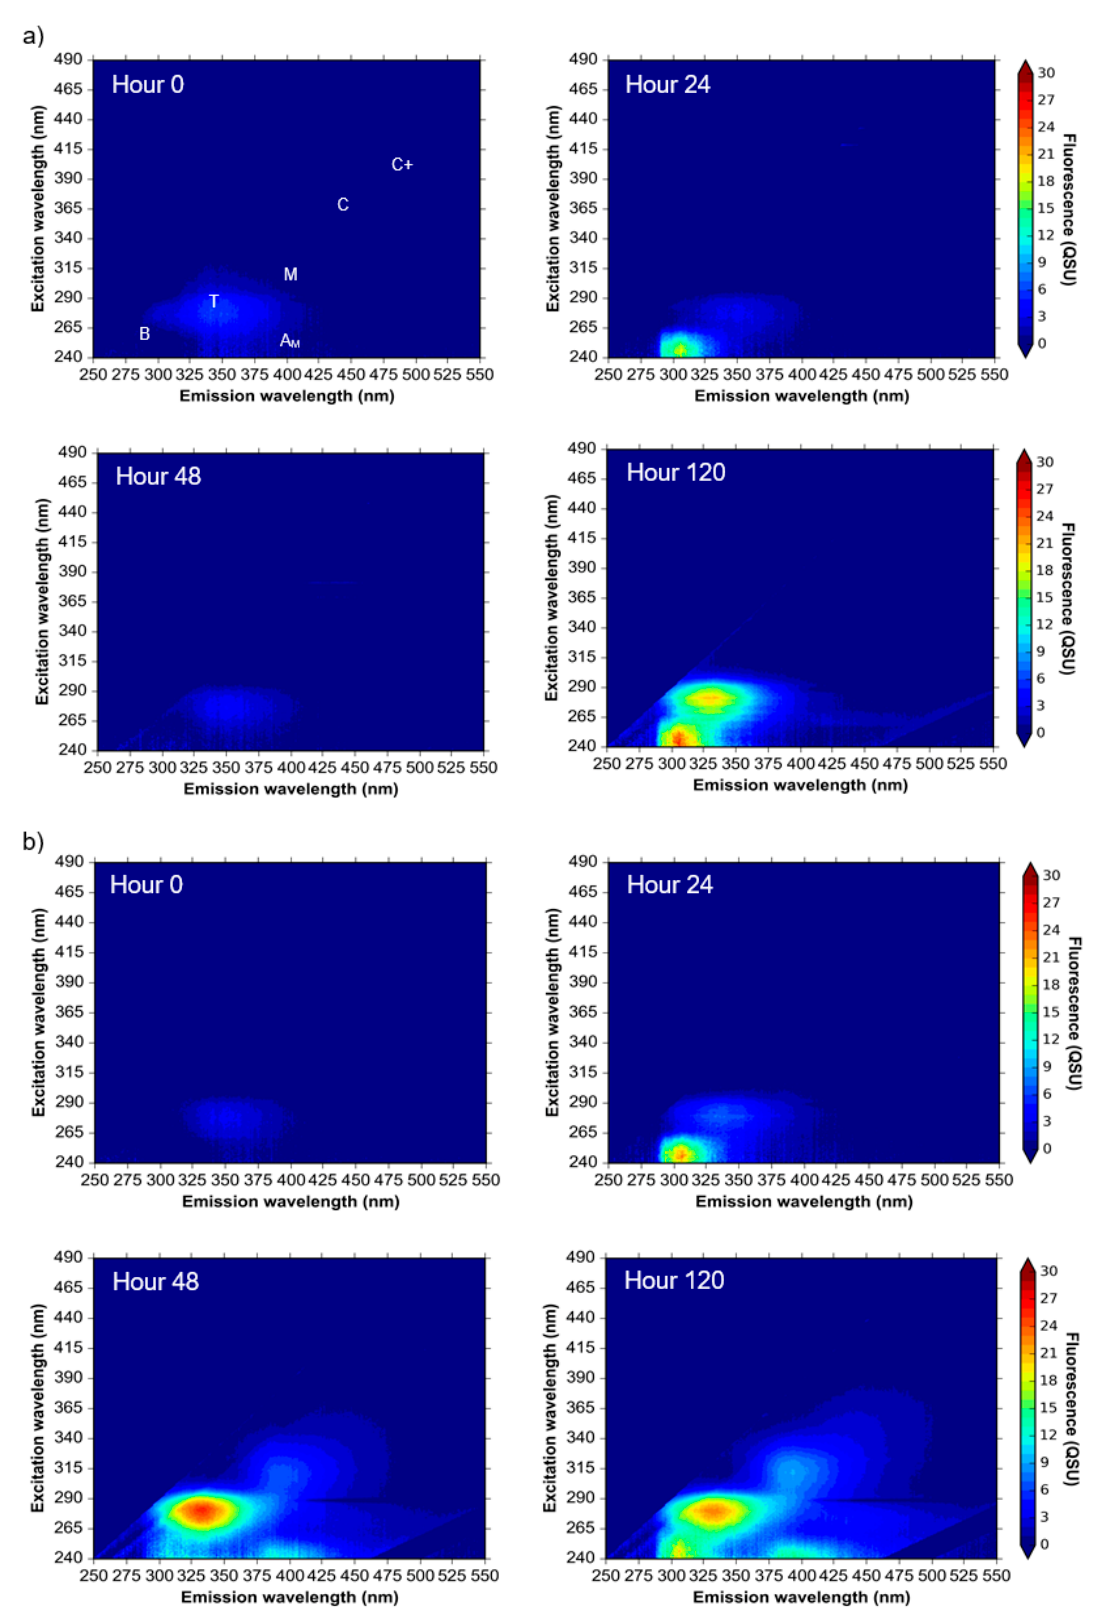
Figure 4. Excitation-emission matrices of synthetic water samples incubated at ( a ) 20 ◦ C and ( b ) 37 ◦ C over a five-day microbial processing period (analysis performed hourly during the first 48-h). Colour bars are in quinine sulphate units, QSU (1 QSU = 1 μ g L − 1 quinine sulphate).